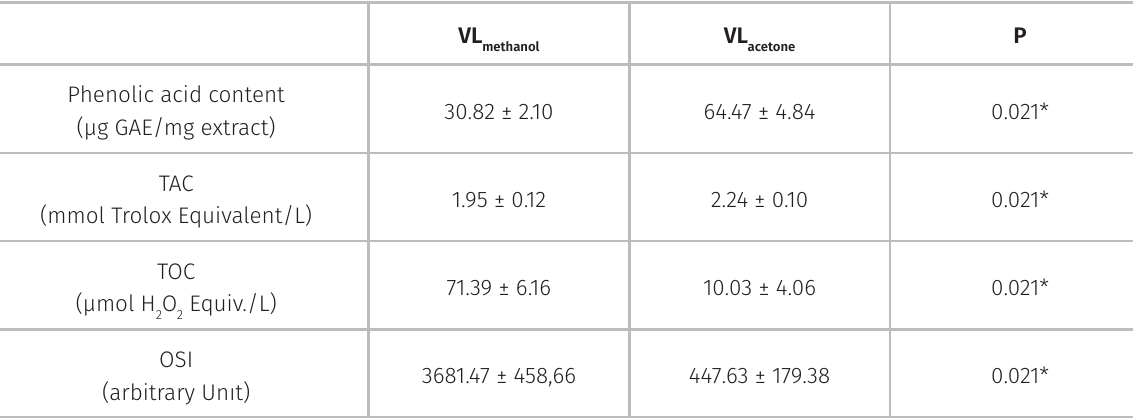
Table II. Phenolic acid content, and TAC, TOC and OSI levels in Verbascum lasianthum Boiss. ex Benth.